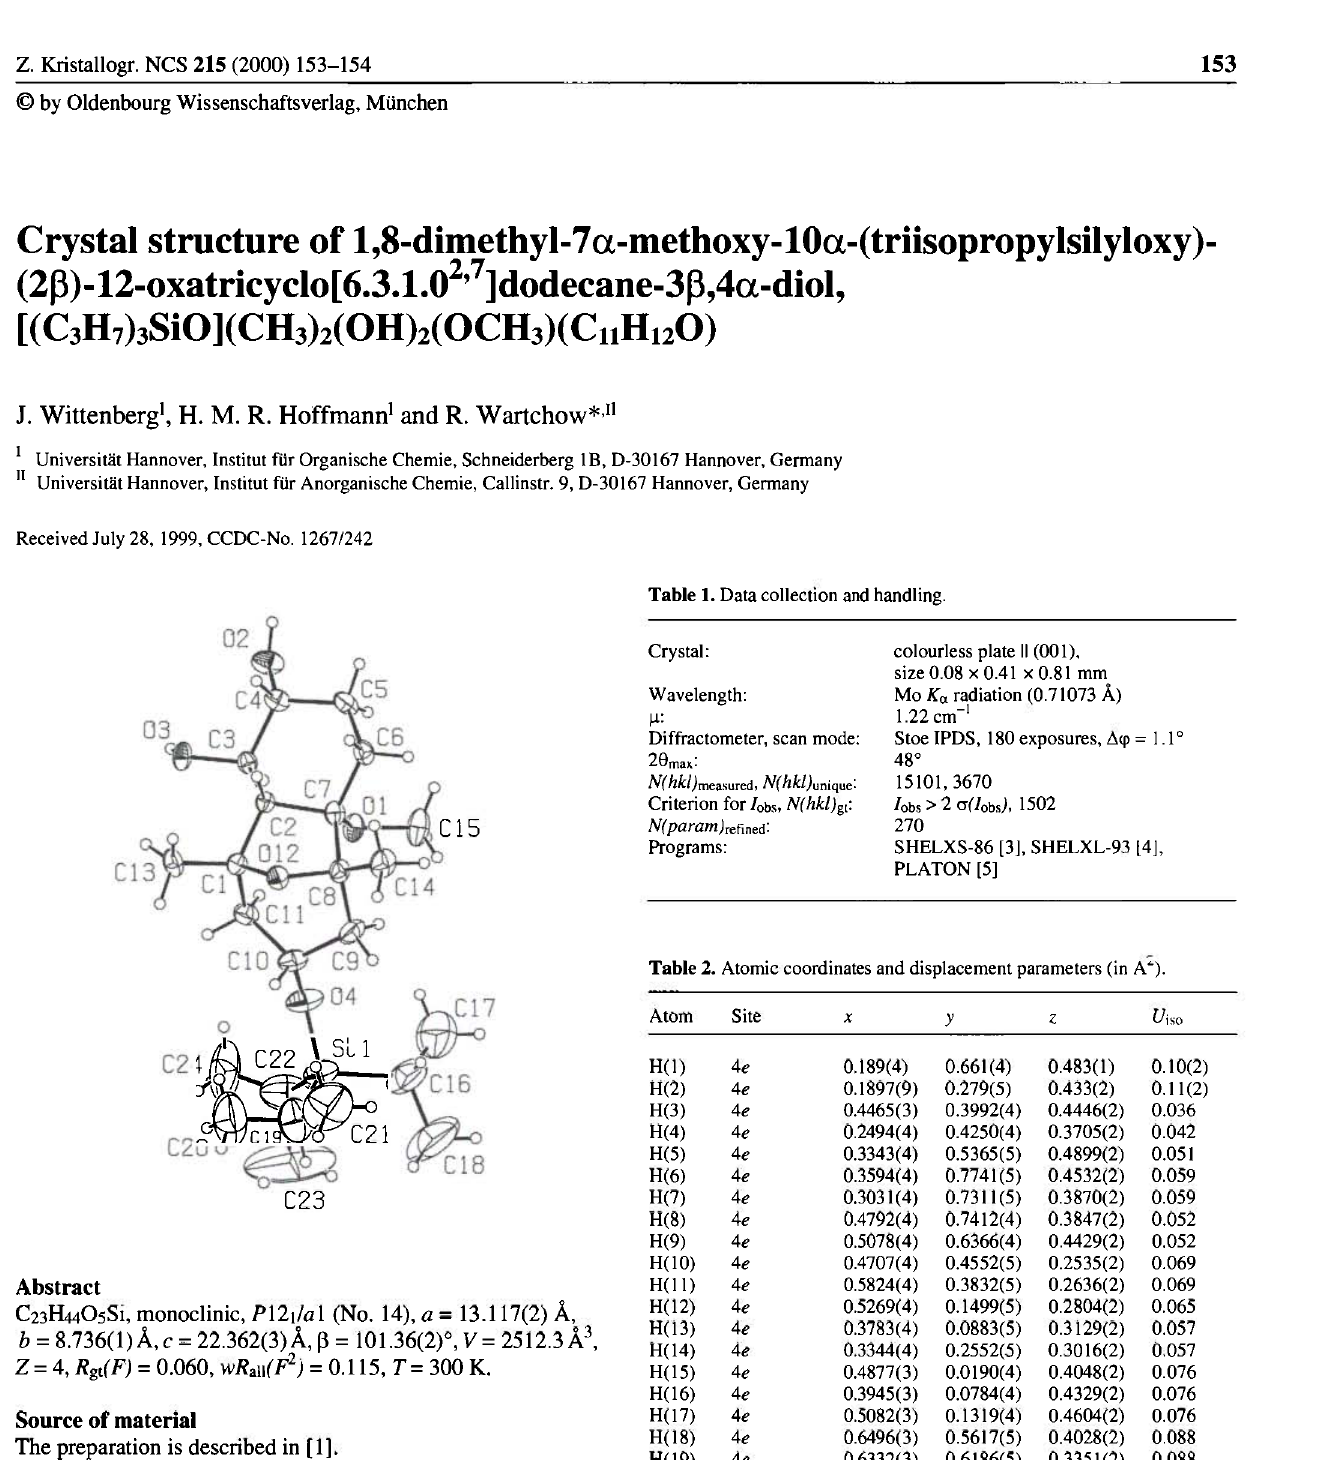
Table 2. Atomic coordinates and displacement parameters (in A